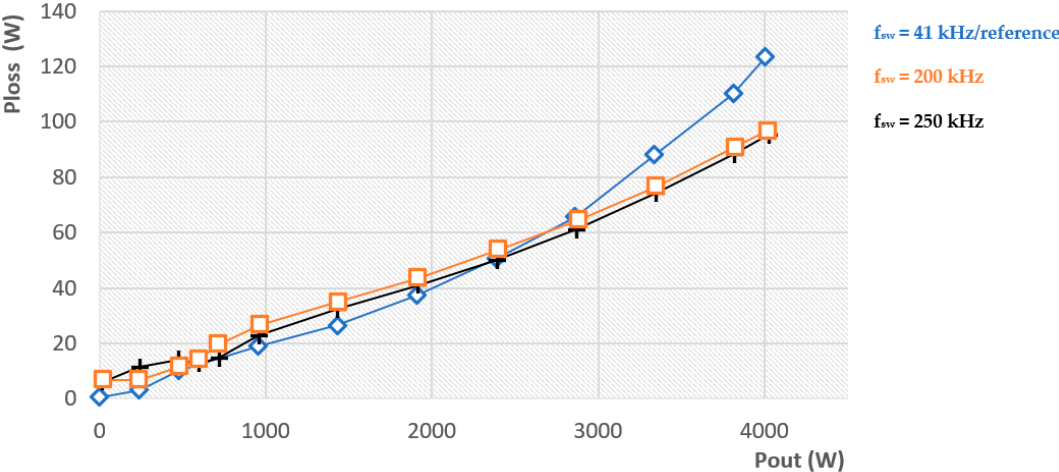
Figure 17. Power losses of PFC converter equipped with IGT60R070D1 GaN transistor in dependency on the output power and switching frequency (blue line—referenced non-optimized solution).